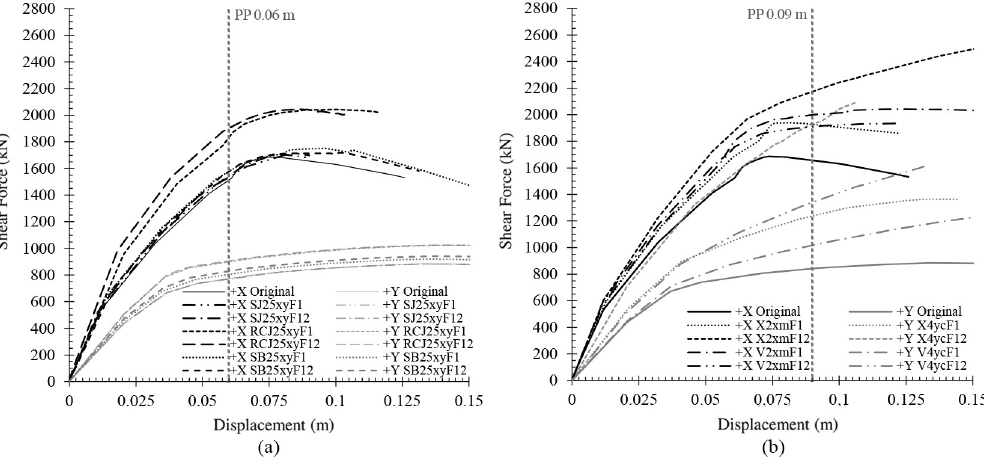
Fig 7. Capacity curves of the models adding techniques of minimum (a) and maximum (b) architectural impact in both directions.